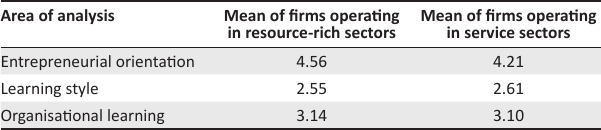
TABLE 1: Mean values by organisational